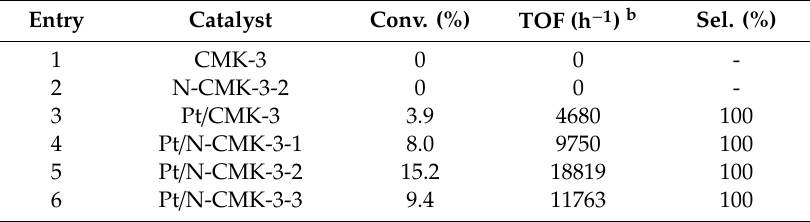
Table 4. Catalytic hydrogenation of nitrobenzene over di ff erent catalysts a .